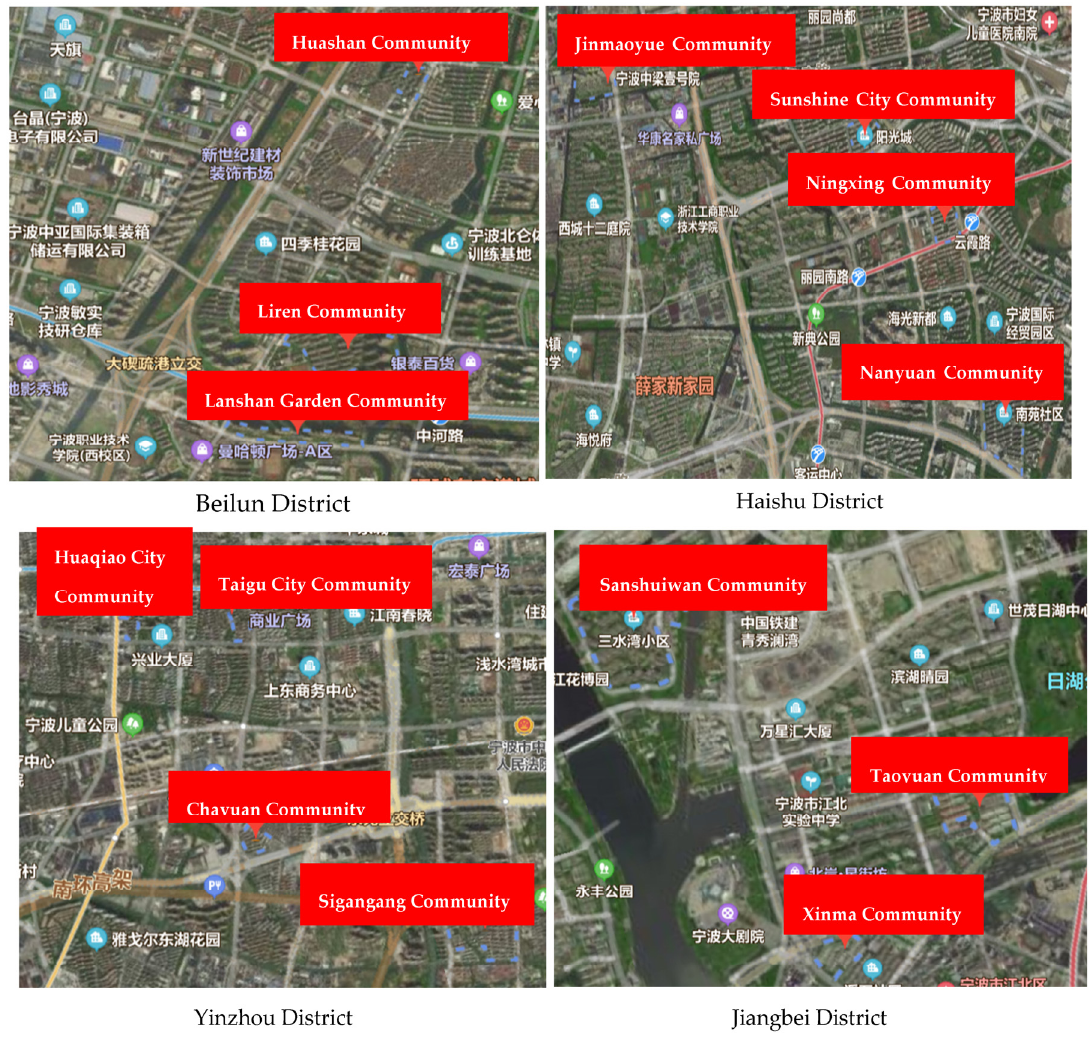
Figure 1. Survey areas.